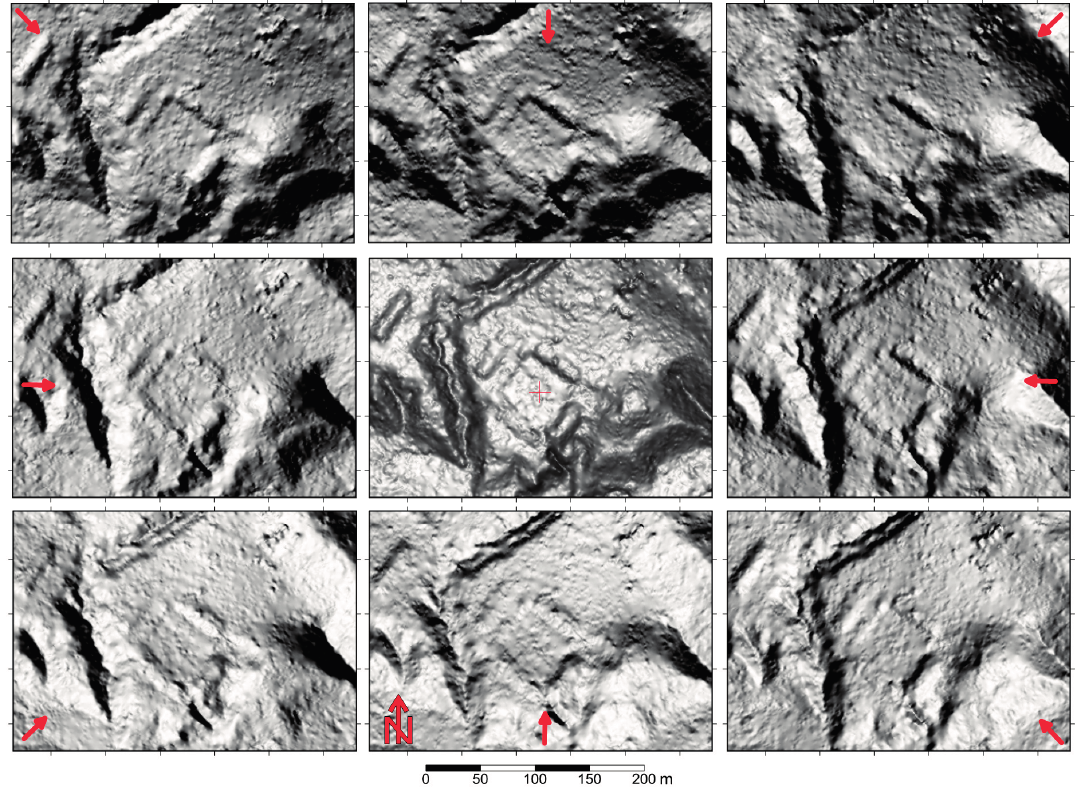
Figure 22. Shaded relief images generated at different illumination angles. Red arrows denote the direction of the illumination, from: ( a ) NW; ( b ) N; ( c ) NE; ( d ) W; ( e ) zenith; ( f ) E; ( g ) SW; ( h ) S; ( i )